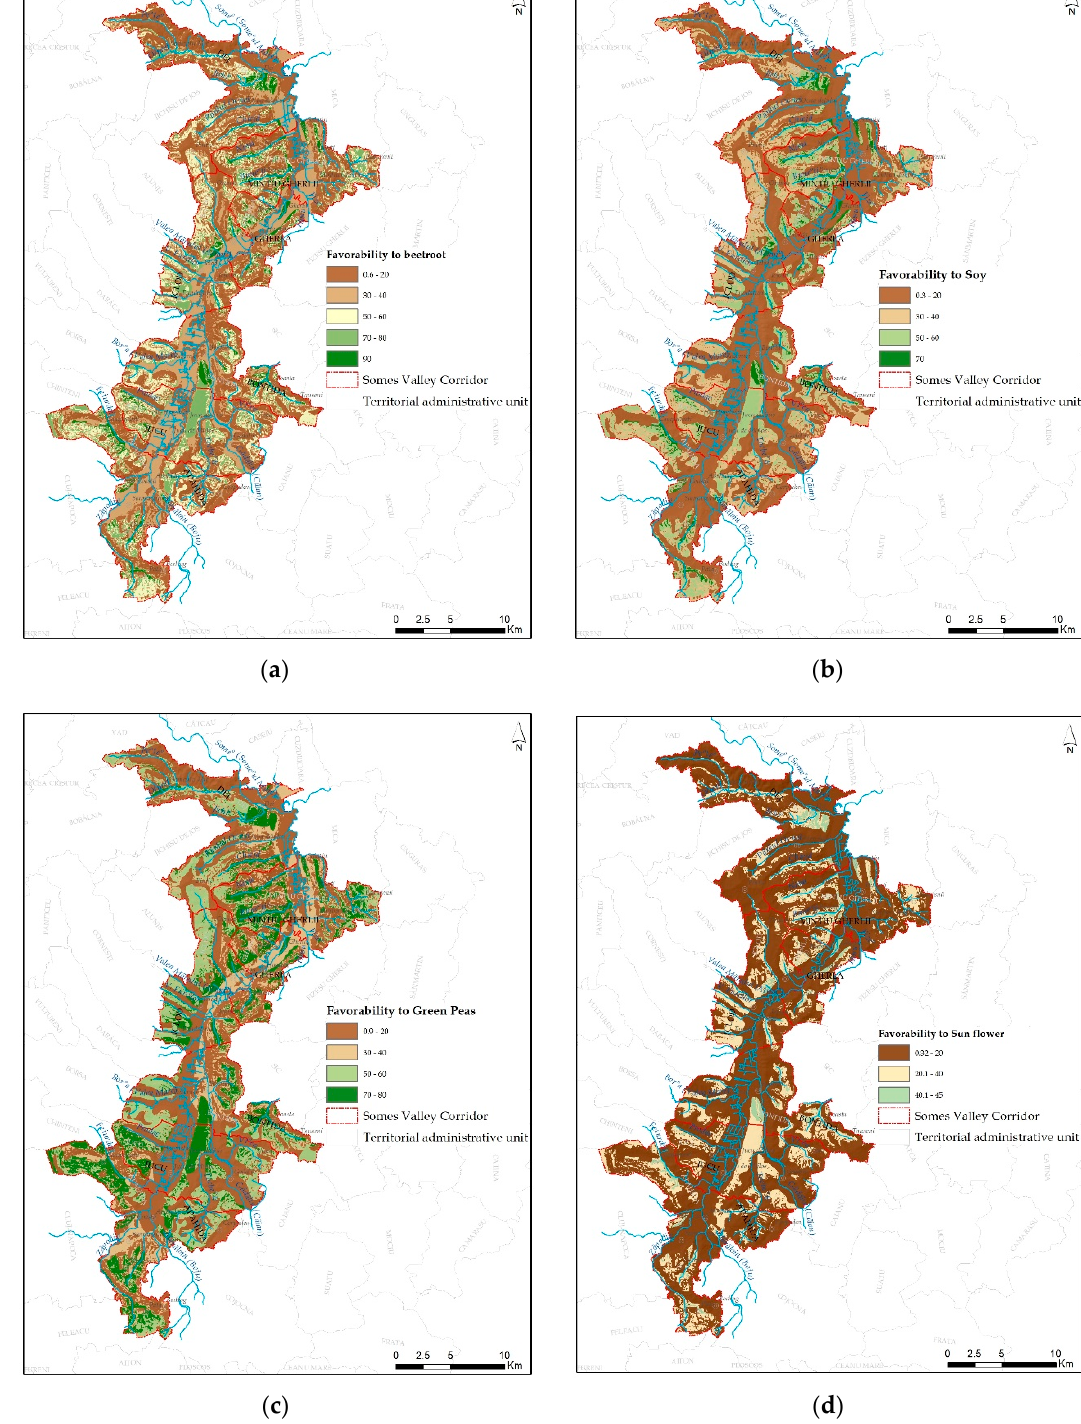
Figure 5. ( a ) Land favourability for beetroot. ( b ) Land favourability for soy. ( c ) Land favourability for green peas. ( d ) Land favourability for sunflower.